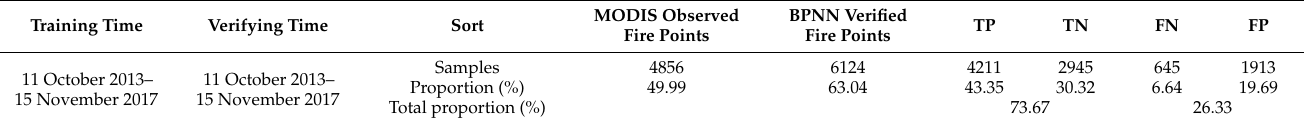
Table 2. Comparison of the results of the BPNN in forecasting fire points over Northeastern China from 2013–2017, when considering five meteorological variables (Scenario 1); (TP) both the forecast and the observations indicate burning, (TN) both the forecast and the observations indicate no burning, (FN) the observations indicate burning, but the forecast indicates no burning, and (FP) the observations indicate no burning, but the forecast indicates burning.